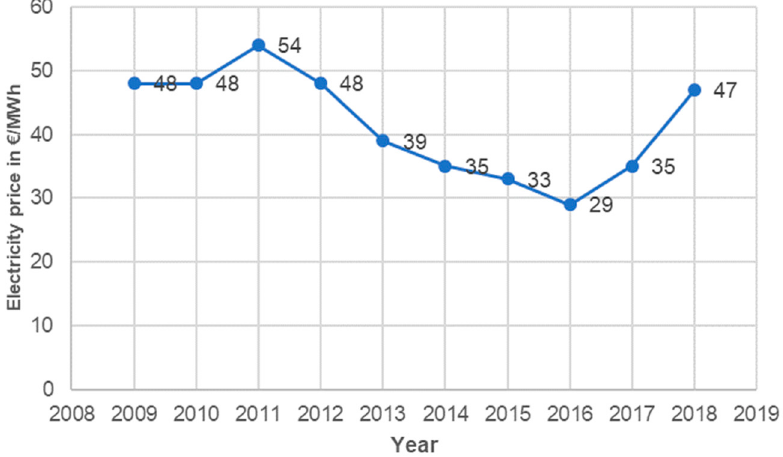
Figure 3. Electricity end user prices development on the stock market—the index PXE (Source: [33]).